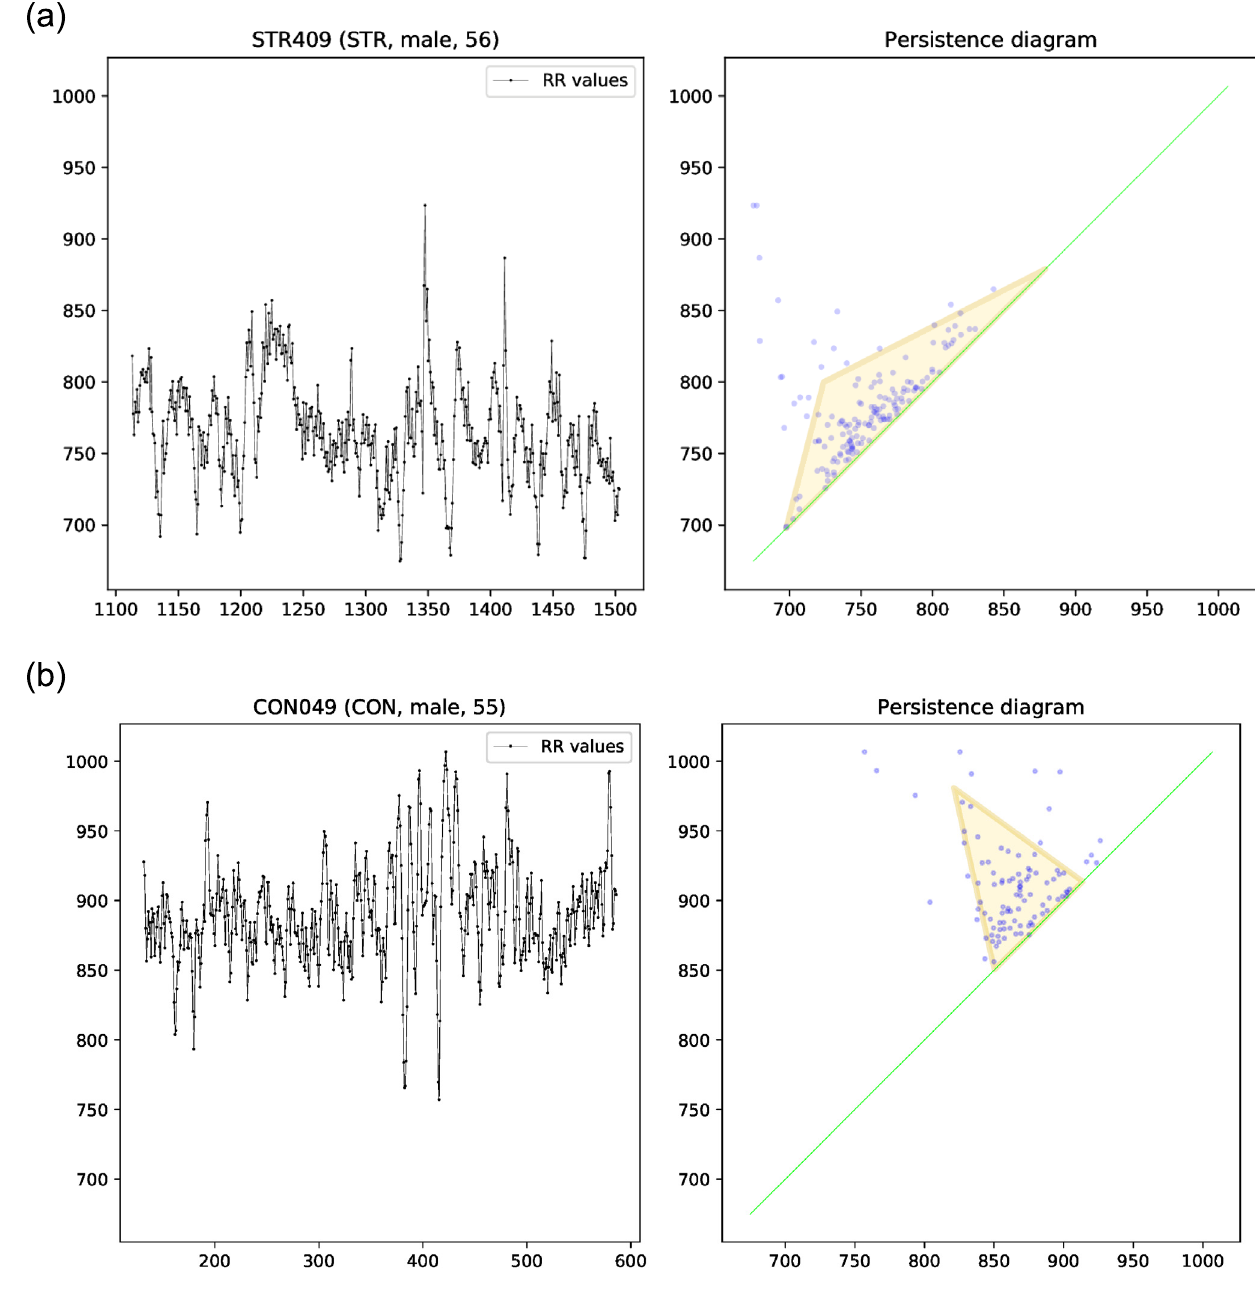
Fig 10. Comparison of tachograms (left) and persistence diagrams (right) in a patient with an acute ischemic stroke (STR, male, 56 years old, upper panel) and a healthy person (CON, male, 55 years old, bottom panel). See text for